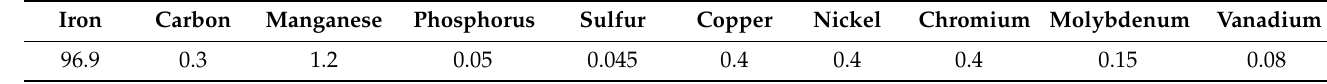
Table 1. Chemical composition (wt.%) of ASTM A53 carbon steel alloy.